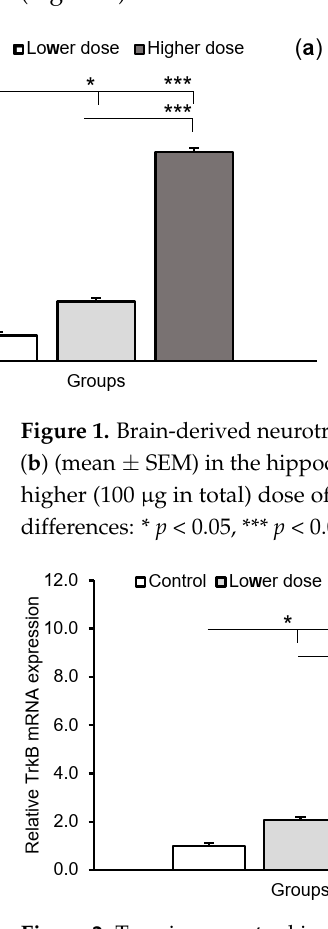
Figure 2. Tyrosine receptor kinase B (TrkB) mRNA expression (mean ± SEM) in the hippocampal CA1 field of sheep infused with the lower (20 μ g in total) and higher (100 μ g in total) dose of kynurenic acid into the third ventricle of the brain. Significance of differences: * p < 0.05, *** p <